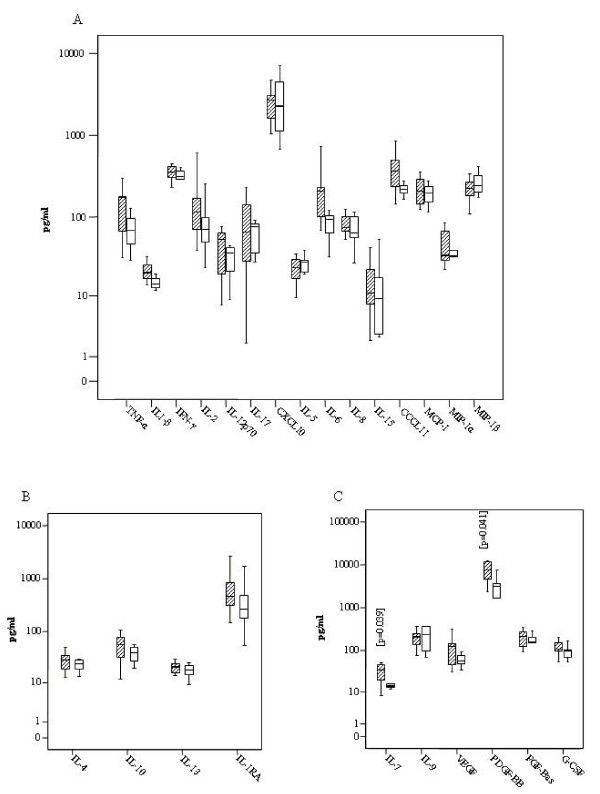
Distribution of cytokines among Type 2 reaction leprosy patients (traced boxes) and controls without reaction (white boxes). (A) Pro inflammatory Cytokines (B) Anti Inflammatory cytokines (C) Growth Factors, IL-7 and PDGF-BB median values were statistically higher among cases than in the control group. Boxes encompass 25th and 75th percentiles of each cytokine distribution. Black lines within boxes refer to the median values.